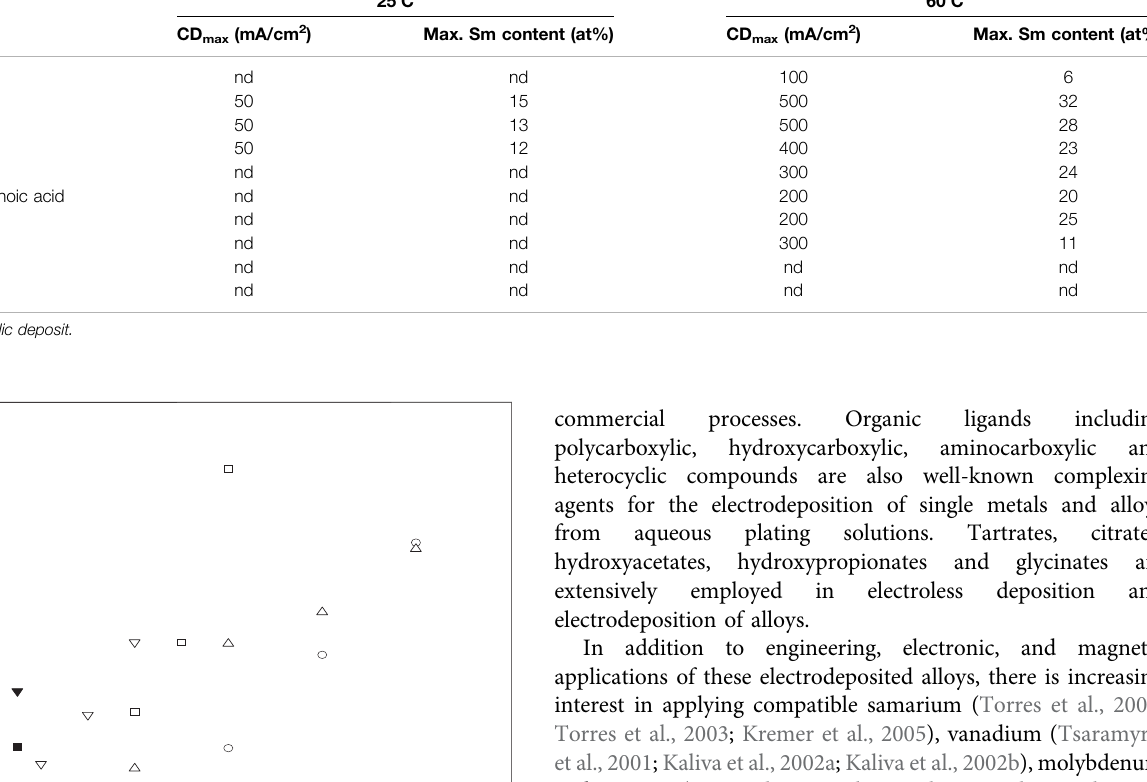
TABLE 1 | Summary of CD max and max. Sm contents obtained from solutions containing different complexers.